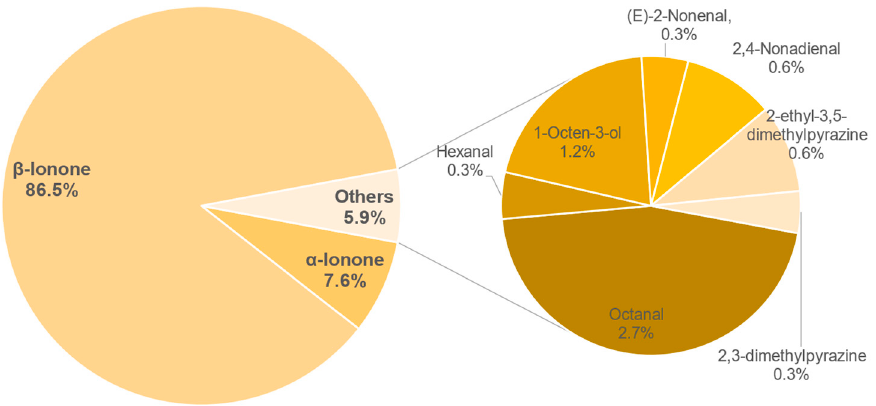
Figure 21. Percentage of OAV of each compound in the total aroma of sample 369.